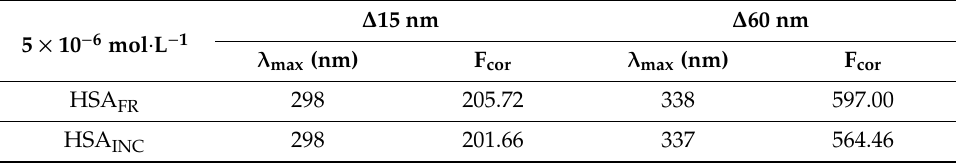
Table 3. Intensity of 5 × 10 − 6 mol · L − 1 HSA FR and HSA INC synchronous fluorescence